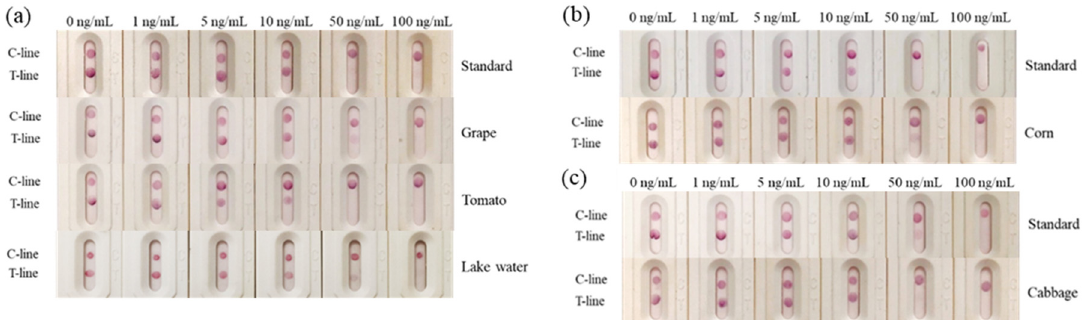
Figure 7. Spiked samples analysis; ( a ) the grapes, tomatoes and river water samples; ( b ) the cabbage samples; ( c ) the corn samples.